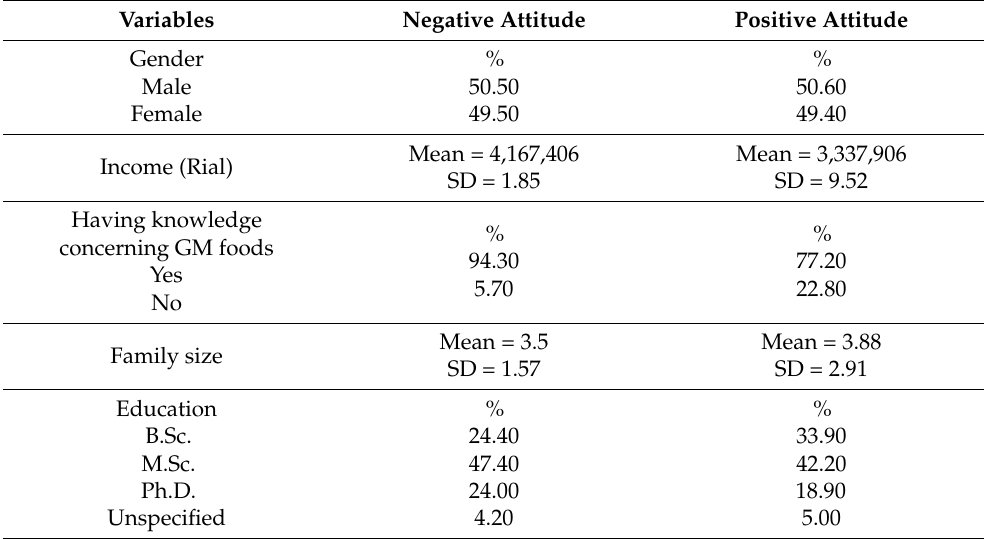
Table 2. Respondents’ demographic characteristics based on their GM